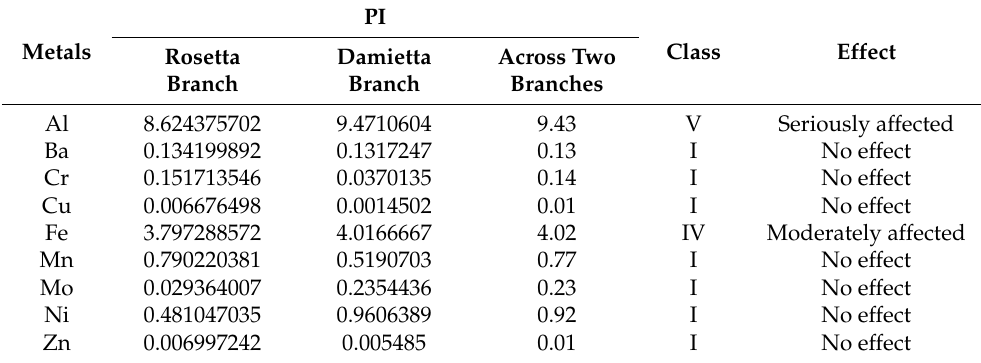
Table 6. Evaluation of surface water quality based on the effects of metals across the Nile